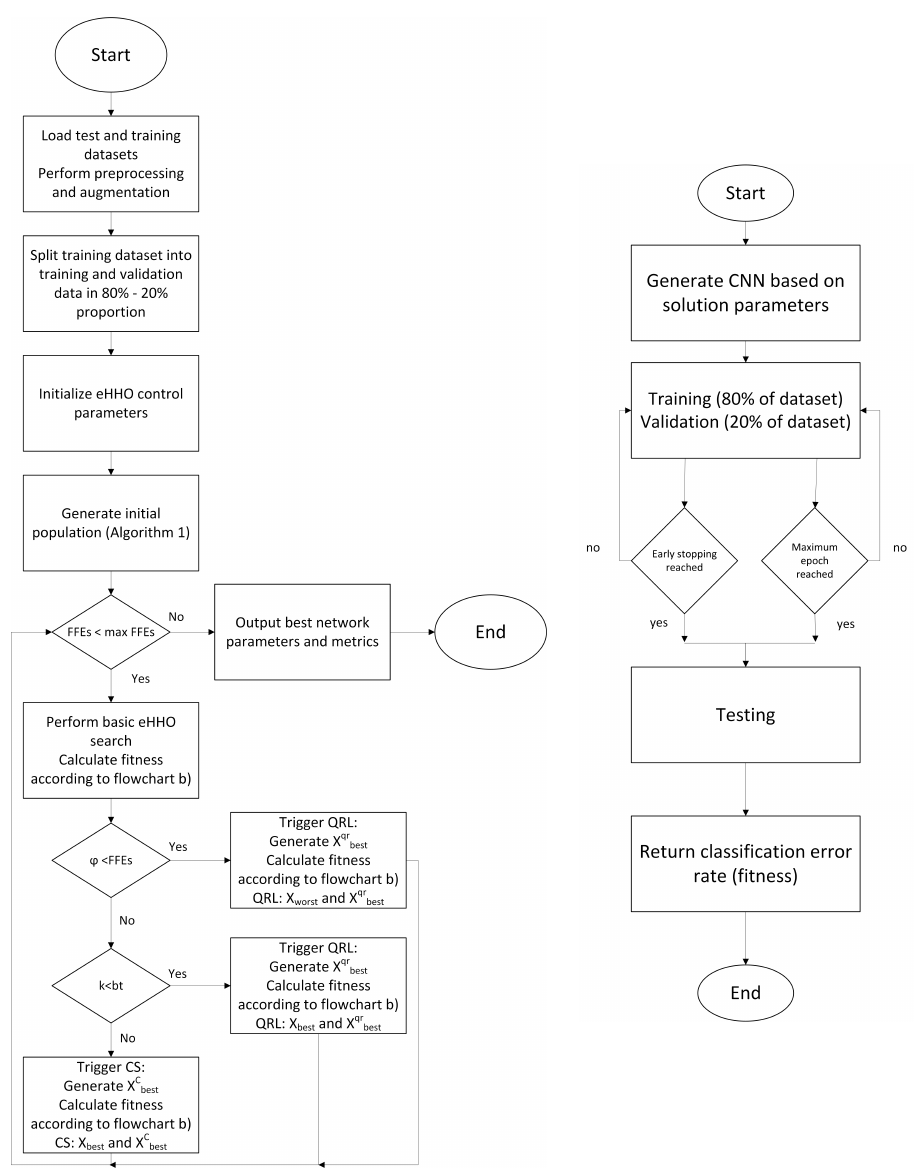
Figure 6. CNN + eHHO main flowchart ( left ); CNN + eHHO flowchart for calculating fitness ( right